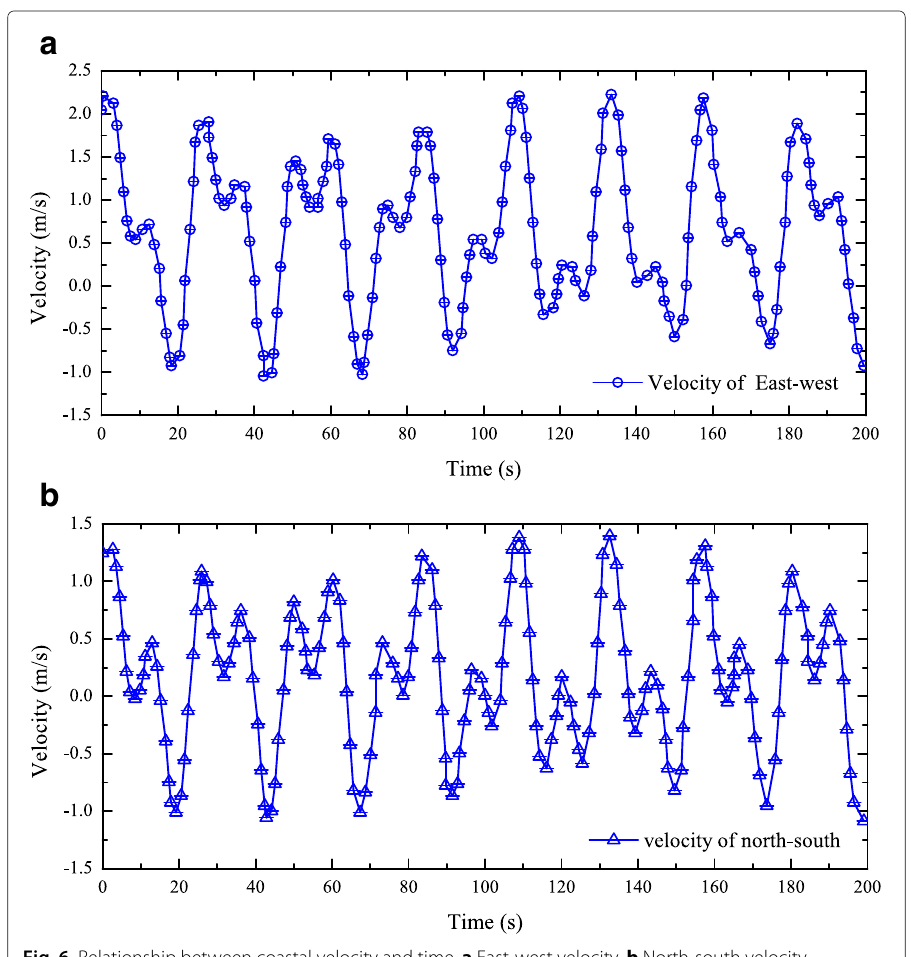
Fig. 6 Relationship between coastal velocity and time. a East-west velocity. b North-south velocity